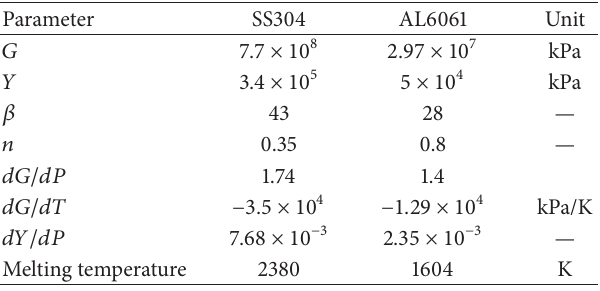
Table 3: Description of numerical model of 2D expanding